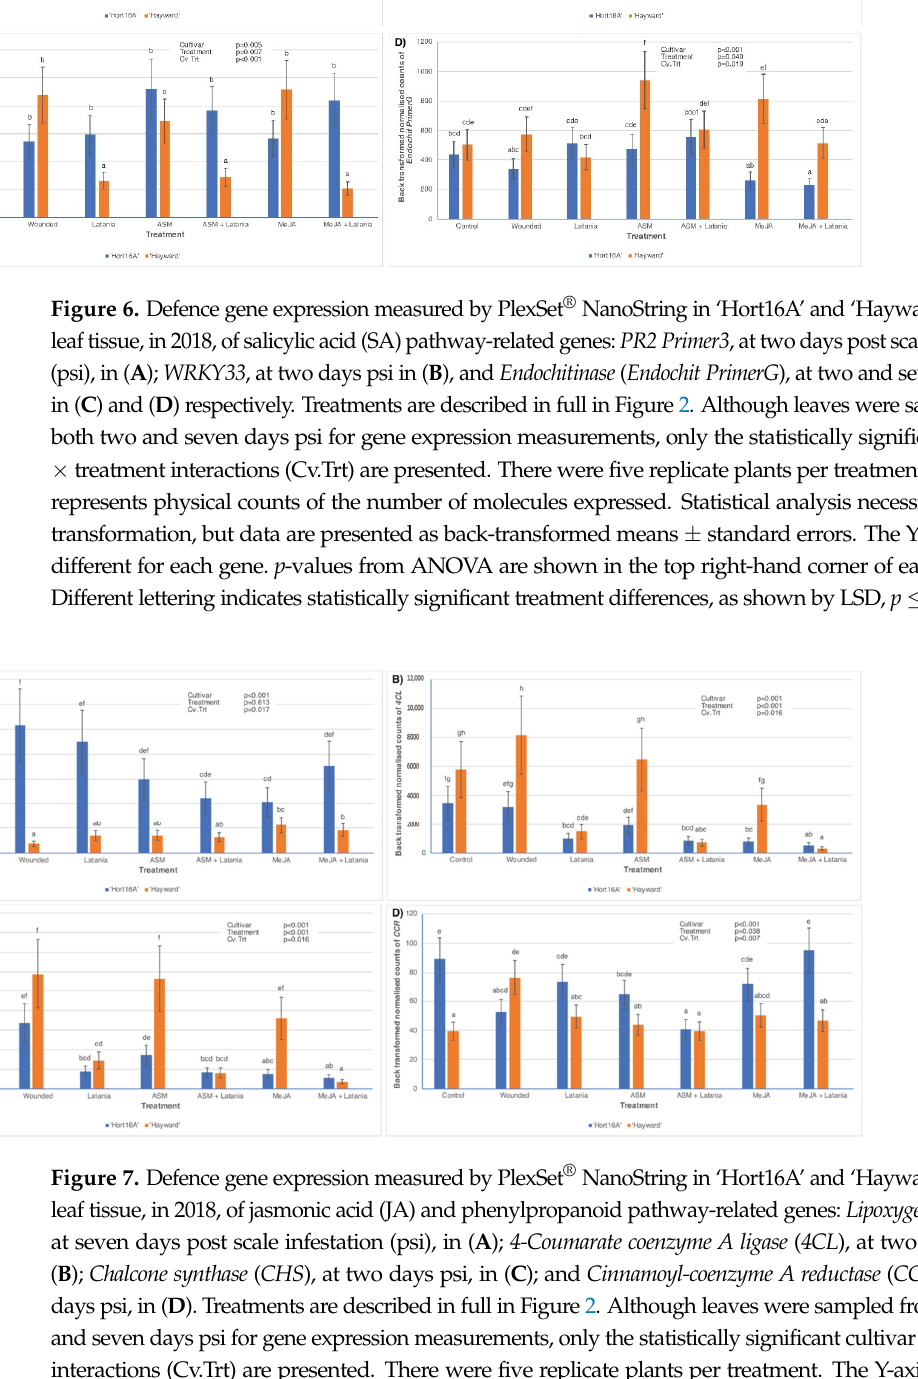
Figure 7. Defence gene expression measured by PlexSet ® NanoString in ‘Hort16A’ and ‘Hayward’ kiwifruit leaf tissue, in 2018, of jasmonic acid (JA) and phenylpropanoid pathway-related genes: Lipoxygenase ( LOX2 ), at seven days post scale infestation (psi), in ( A ); 4-Coumarate coenzyme A ligase ( 4CL ), at two days psi, in ( B ); Chalcone synthase ( CHS ), at two days psi, in ( C ); and Cinnamoyl-coenzyme A reductase ( CCR ), at seven days psi, in ( D ). Treatments are described in full in Figure 2. Although leaves were sampled from both two and seven days psi for gene expression measurements, only the statistically significant cultivar × treatment interactions (Cv.Trt) are presented. There were five replicate plants per treatment. The Y-axis represents physical counts of the number of molecules expressed. Statistical analysis necessitated a log 2 transformation, but data are presented as back-transformed means ± standard errors. The Y-axis scale is different for each gene. P-values from ANOVA are shown in the top right-hand corner of each bar chart. Different lettering indicates statistically significant treatment differences, as shown by LSD, p ≤